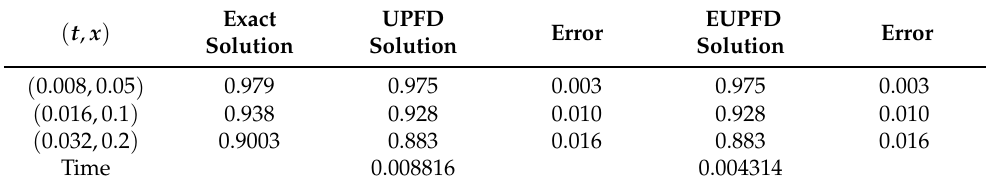
Table 3. Numerical results of the linear ADR equation at a fixed ∆ x = 0.025 and ∆ t = 0.004 . ( t , x )